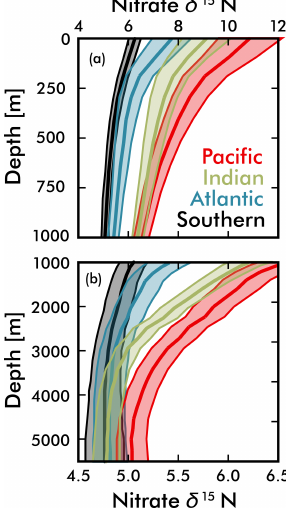
Figure 7. Mean EANN nitrate δ 15 N (solid line) and 1 σ standard deviation (envelope) with depth for each ocean basin. Note change in vertical and horizontal axes between (a) and (b)